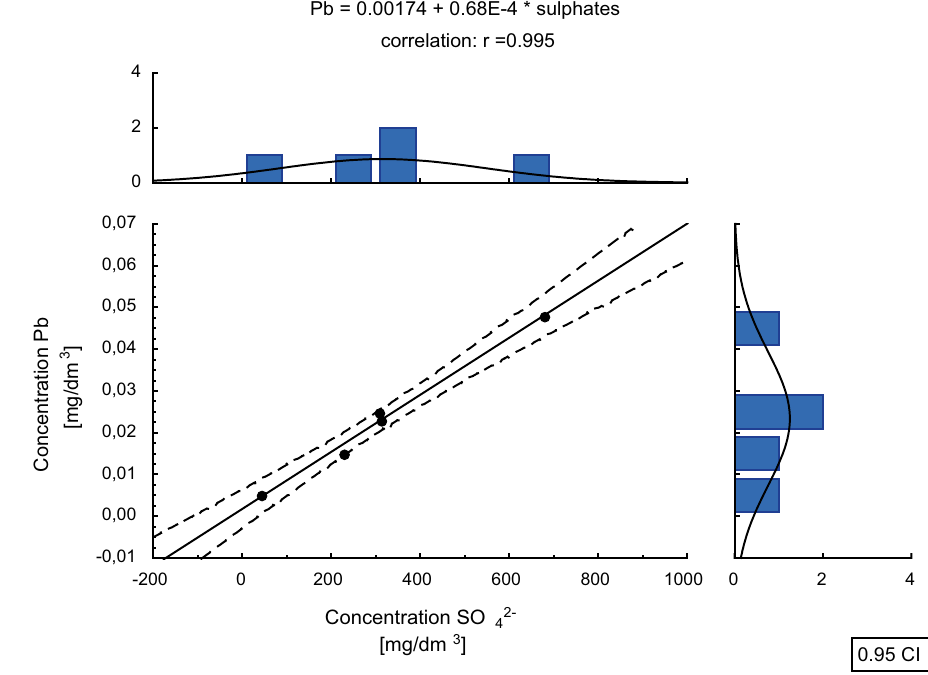
Fig. 3 Categorised graph of dispersion with regression line for lead and